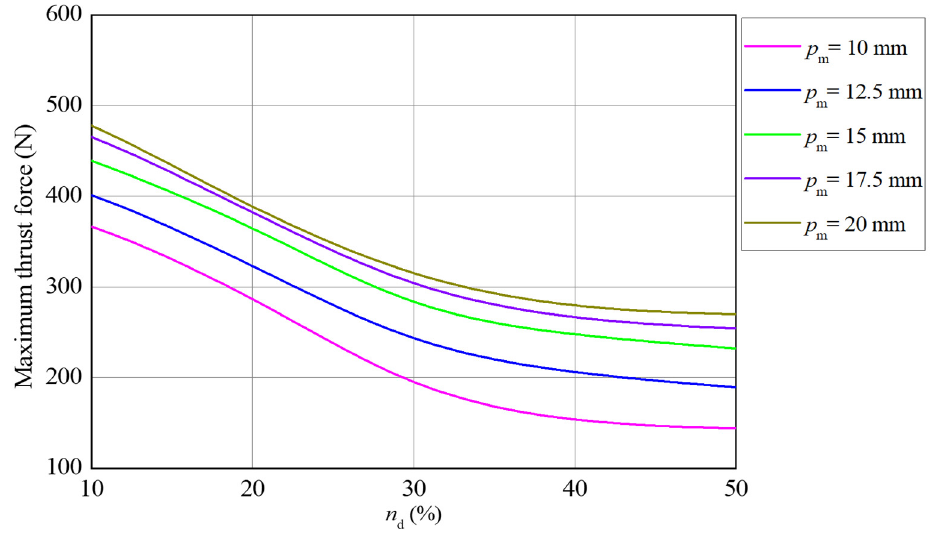
Figure 9. Variation in thrust force with slot ratio n d .